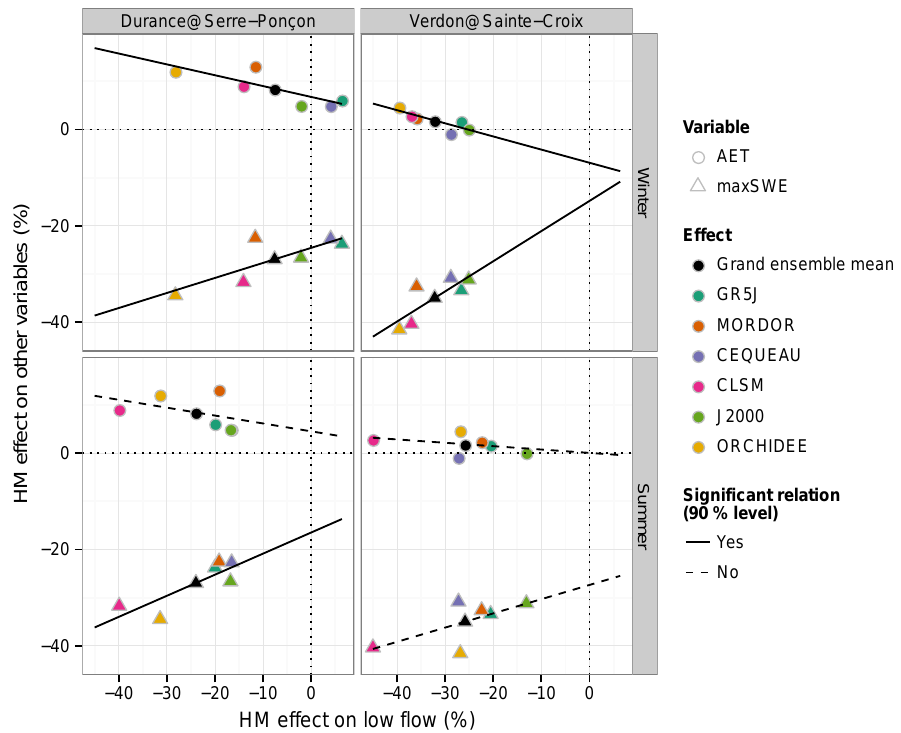
Figure 13. Relations between HM effects on low-flow anomaly and HM effects on AET/maxSWE anomaly for the year 2065. Significant relations at the 90% confidence level are shown with solid